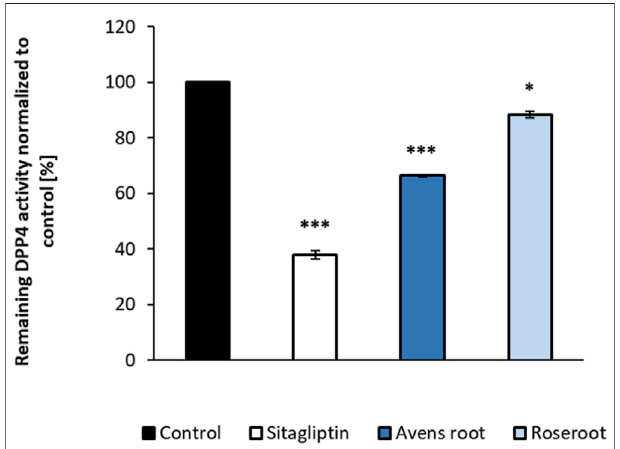
FIGURE 3 | In fl uence of root extracts on the in-vitro activity of dipeptidyl peptidase-4 (DPP4) enzyme activity. DPP4 assays were carried out in the presenceoftheindicatedsubstances(control:assaybuffer;sitagliptin:18 nM; root extracts: 1,000 μ g/ml). The percentage values of remaining DPP4 enzyme activity in comparison to the control are shown. Results are mean values of n (cid:2) 2 duplicate. Error bars indicate the standard deviation. *** p < 0.001, * p < 0.05, with post-hoc multiple comparison test of Dunnett.